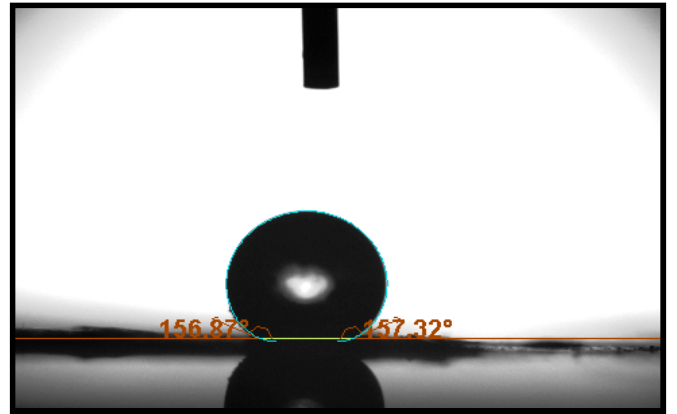
Figure 8. Water-contact image and numerical contact angle values of synthesized SiO 2 NPs.